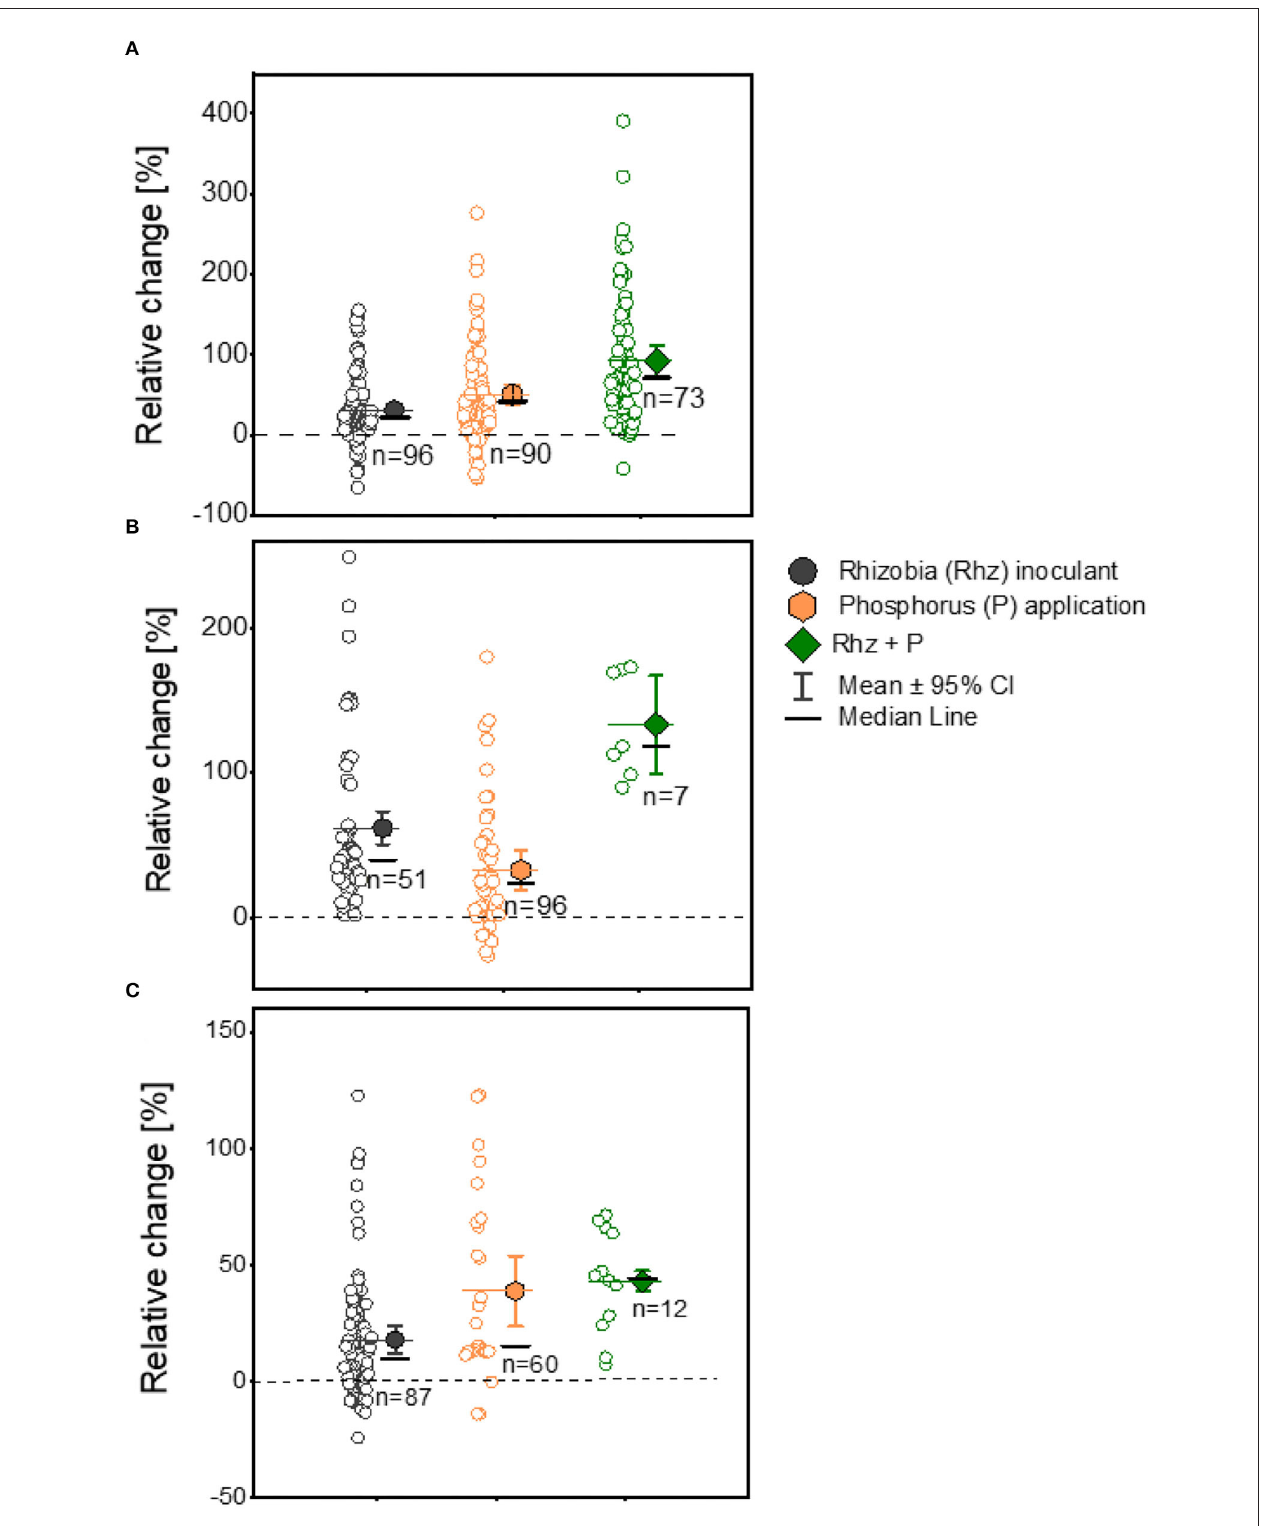
FIGURE 5 | Boxplot and scatter data (open circle symbol) of grain yield responses to rhizobia ( + Rhz) inoculation, phosphorus ( + P) application, and + Rhz + P over the uninoculated (-Rhz), no-P, and -Rhz-no-P treatments for (A) soybean, (B) cowpea, and (C) groundnut plants under Ghana soil. The mean values (different symbols) with a 95% bootstrap confidence interval, the median line, and the sample size are shown.